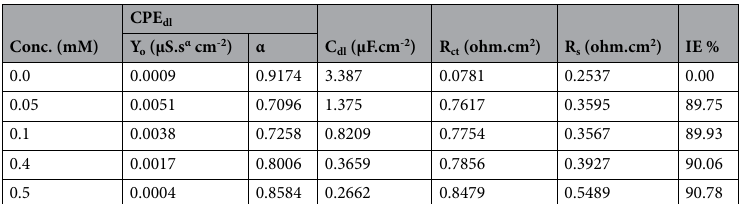
Table 3. CPE data for MS in 1.0 M HCl with various concentrations of nonanedihydrazide at 303 K.